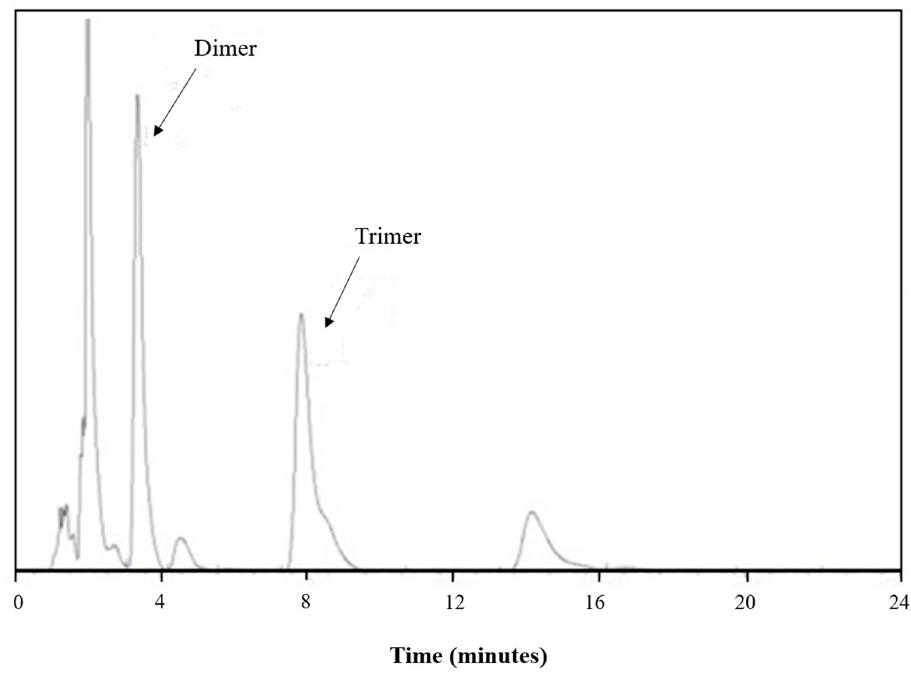
Figure 4. HPLC traces of initial PBT.